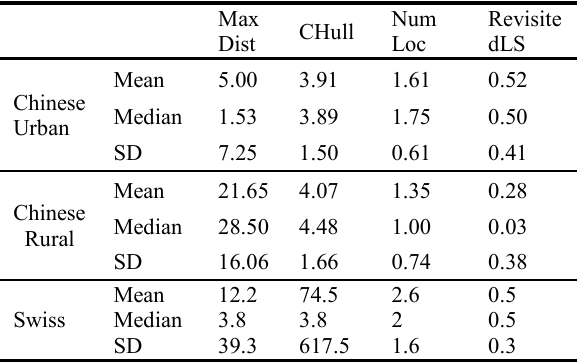
Table 5. The comparison of the raw indicators